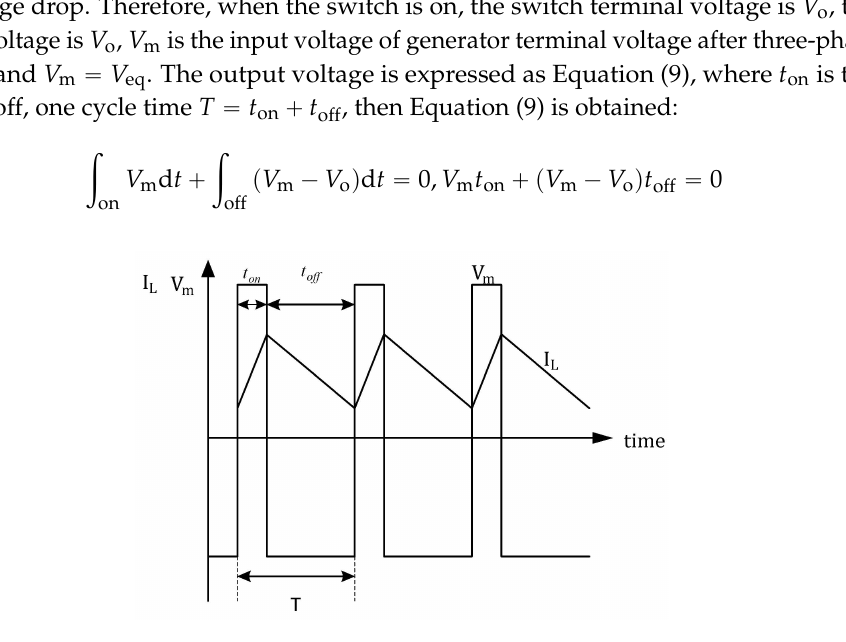
Figure 4. Switching voltage and duty